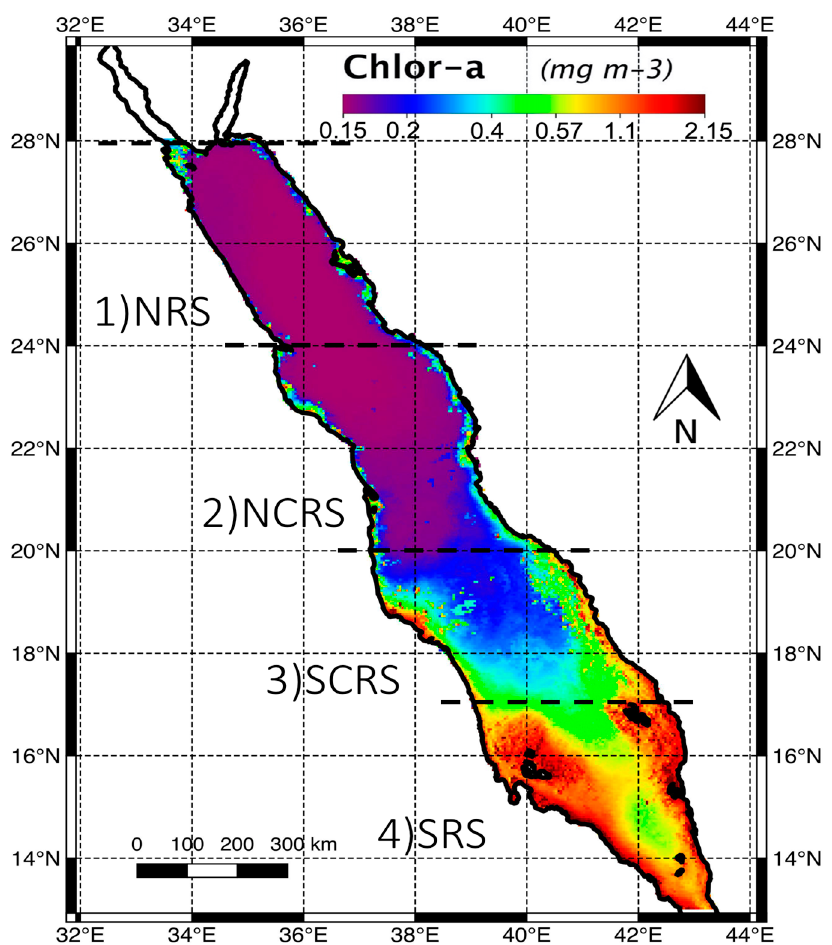
Figure 1. Ocean Color Climate Change Initiative (OC-CCI) Chl- a (mg m − 3 ) Level 3 monthly OC-CCI Chl- a data averaged for the Red Sea from September 1997 to December 2016. The four regions labeled consecutively starting from the north to south are the Northern Red Sea (NRS), North-Central Red Sea (NCRS), South-Central Red Sea (SCRS), and Southern Red Sea (SRS).